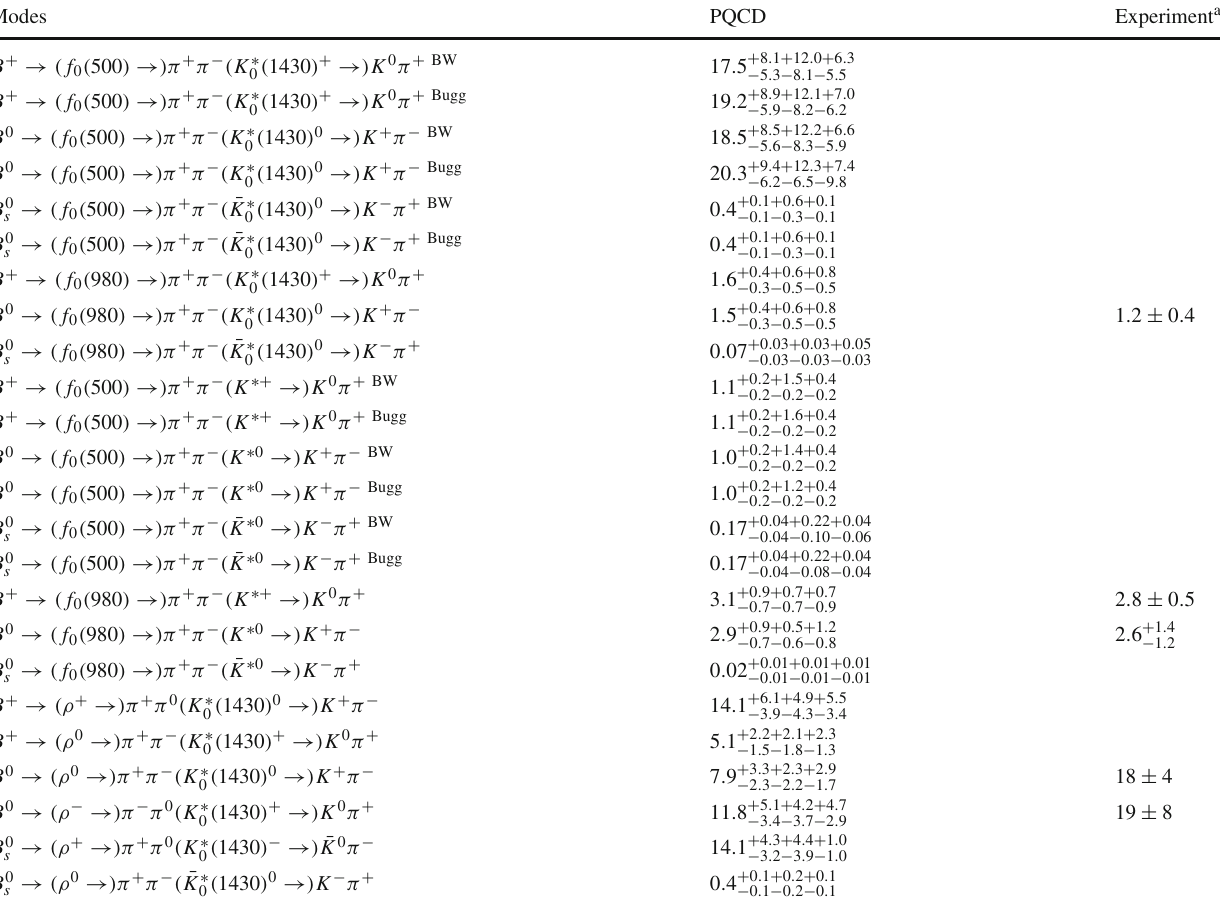
Table 5 CP -averaged branching ratios (in units of 10 − 6 ) for the four-body B → [ SS , SV , V S ] → (ππ)( K π) decays, with S = [ f ( 500 ), f ( 980 ), K ∗ ( 1430 ) ] and V = [ ρ, K ∗ ] . The experimental data are taken from [46]. The sources of the theoretical errors are the same 0 0 0